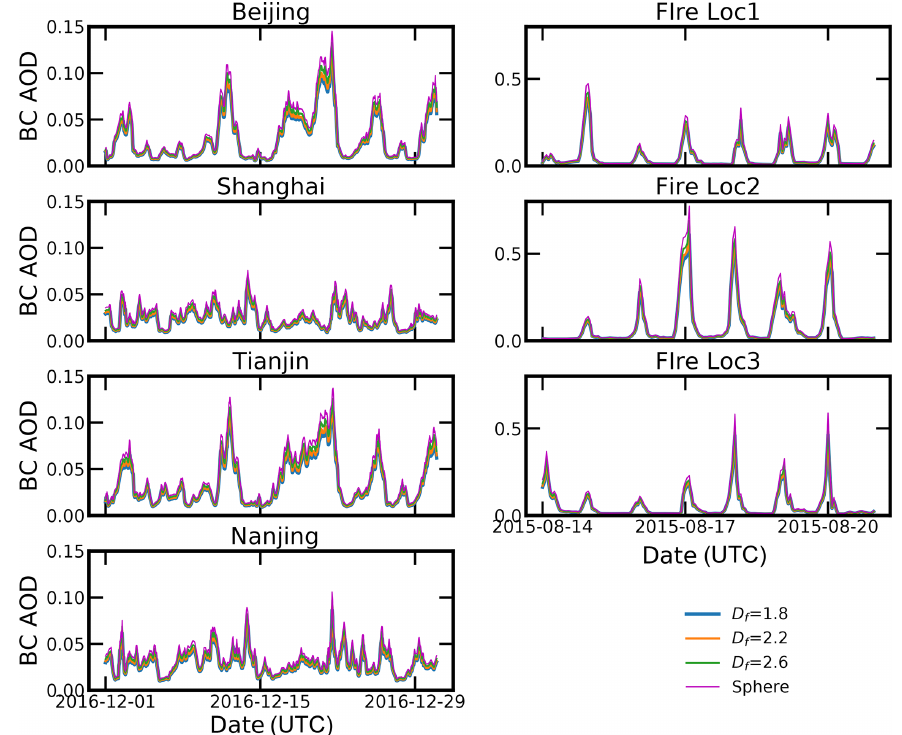
Figure 5. The comparison of BC AOD for different BC morphologies, λ = 550nm.